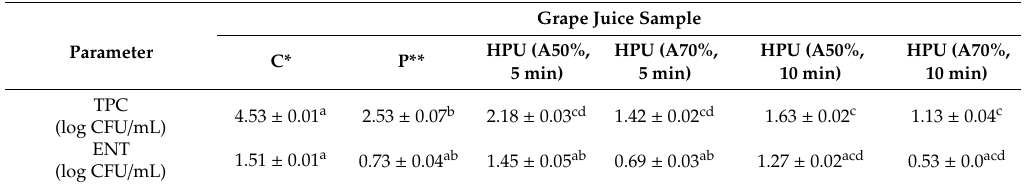
Table 5. Impact of pasteurization and HPU treatments on the total plate count (TPC) and the Enterobacteriaceae count (ENT) of grape